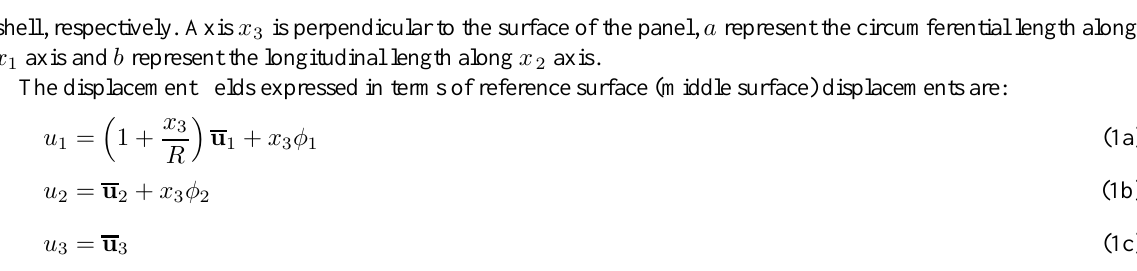
Fig. 1. A cylindrical shell panel showing dimensions, coordinate system and